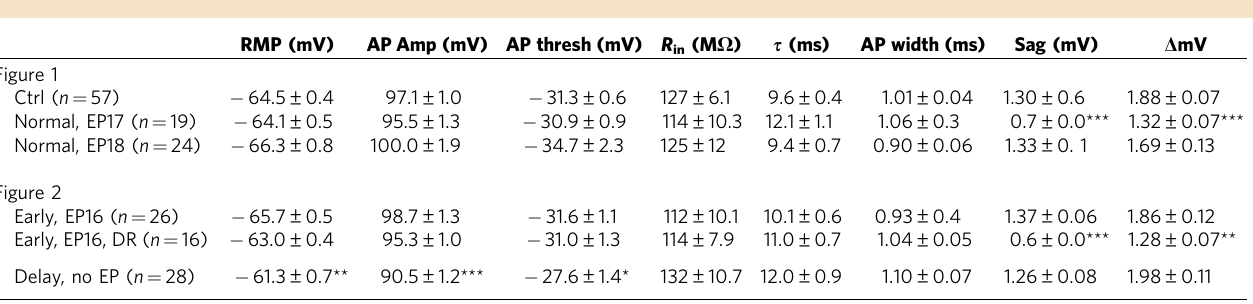
Table 2 | Visual experience regulates the membrane property CP for sensitivity to hearing loss.